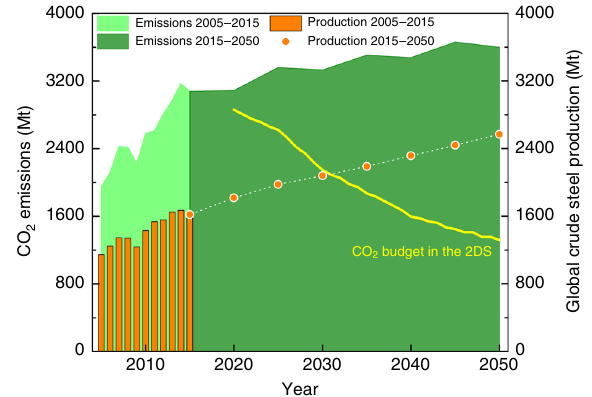
Fig. 1 Sectoral contribution to CO 2 emission reduction in the 2 °C scenario. Evolution of annual crude steel production 9,44 , CO 2 emissions 45,46 , and the